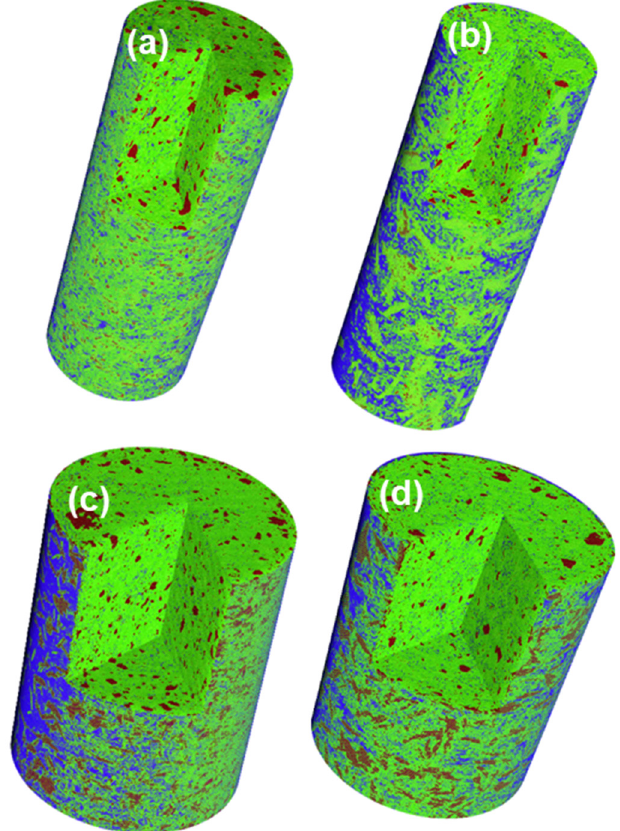
Figure 7. Rendered volumes displaying the results of the segmentations. Color codes: brown—un-